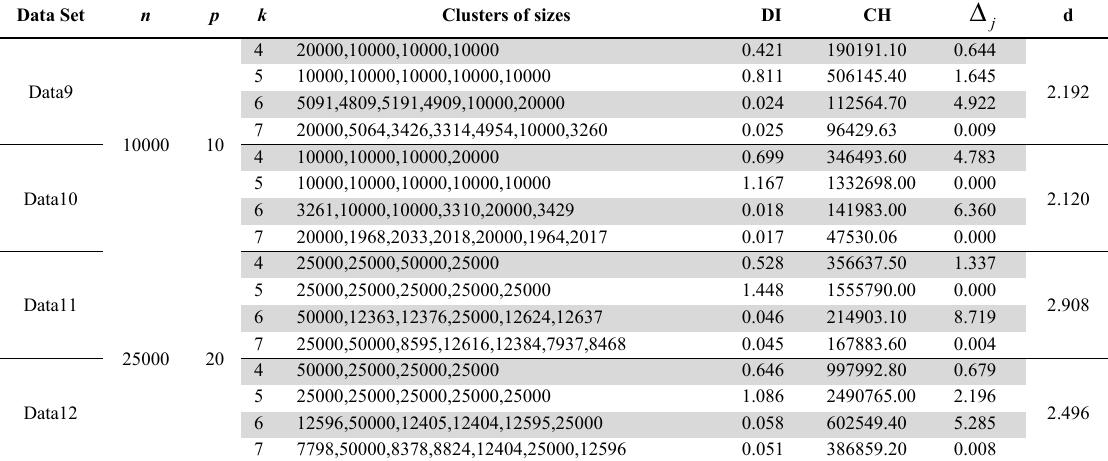
The proposed k -means algorithm was also tested for generated non-normal multivariate data set with three different clusters k=2, 3 and 5 . The values of the constant d for each data set were computed according to the graph as shown in Fig. 7 to Fig. 9. The results of the proposed algorithm and validation indices for non-normal datasets (Data13 – Data18) are presented in Table